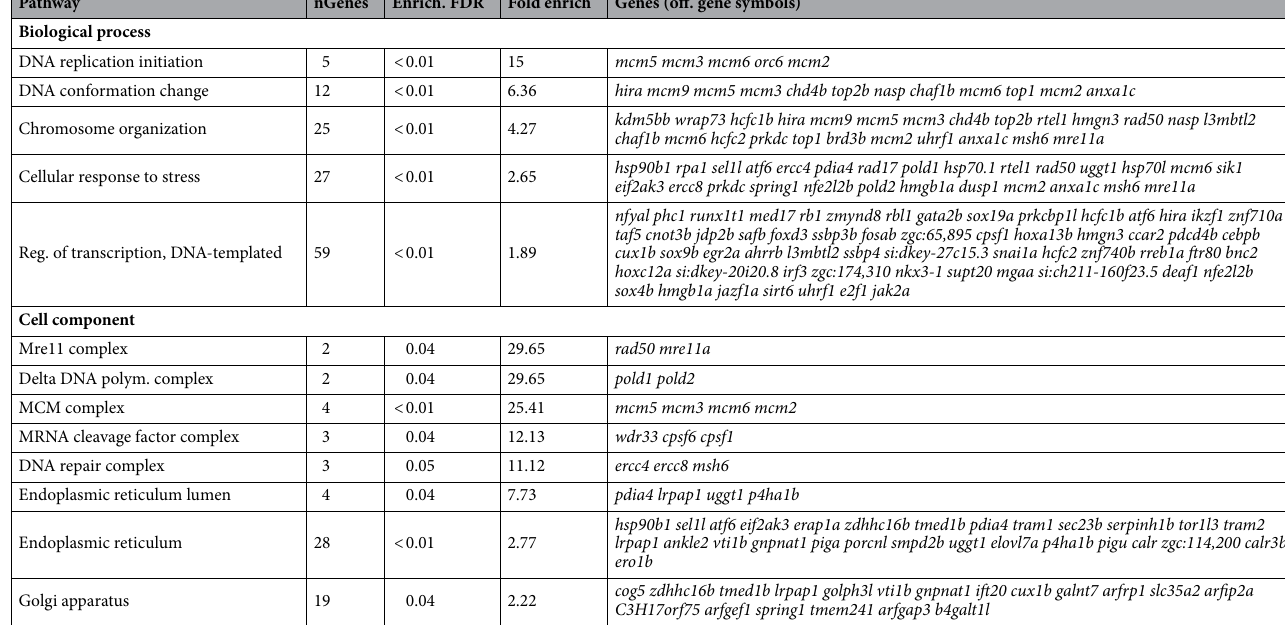
Table 3. Enriched GO (biological processes, FDR < 0.05) associated with genes significantly down-expressed in the heamal region in the recovery (s-L/rec)